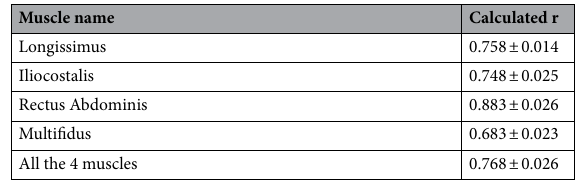
Table 2. Pearson correlation coefficients (r) calculated between measured (EMG) and model predicted muscle activations during the FL phase of DVJ for different trunk